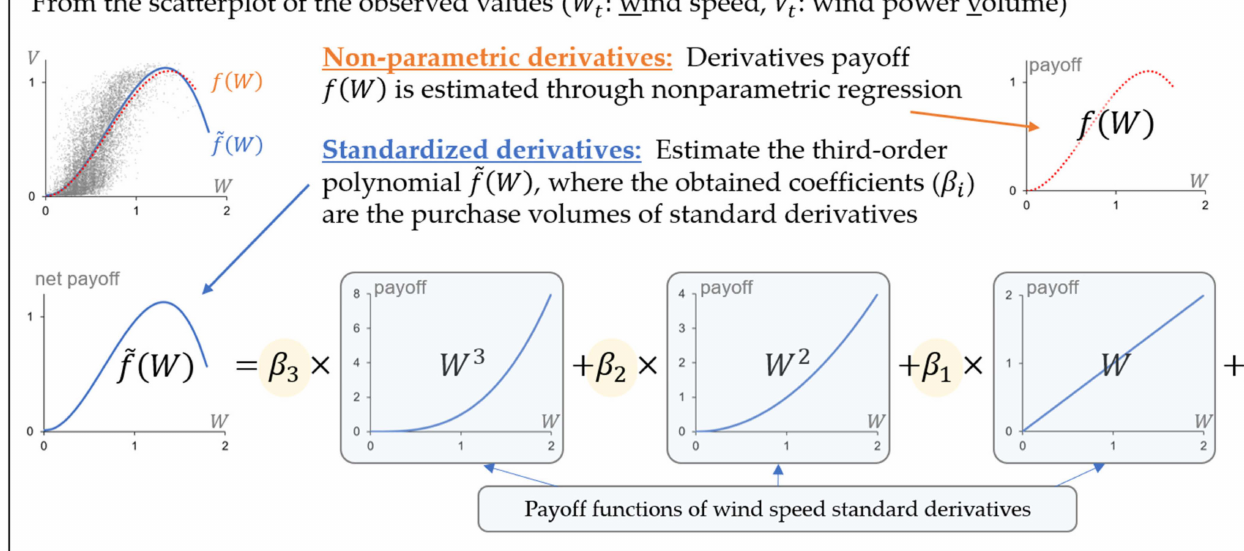
Figure 3. Conceptual diagram of methods for determining standardized (non-parametric) derivatives’ trading volume (payoff functions). Note: this conceptual diagram is an example of using only wind speed